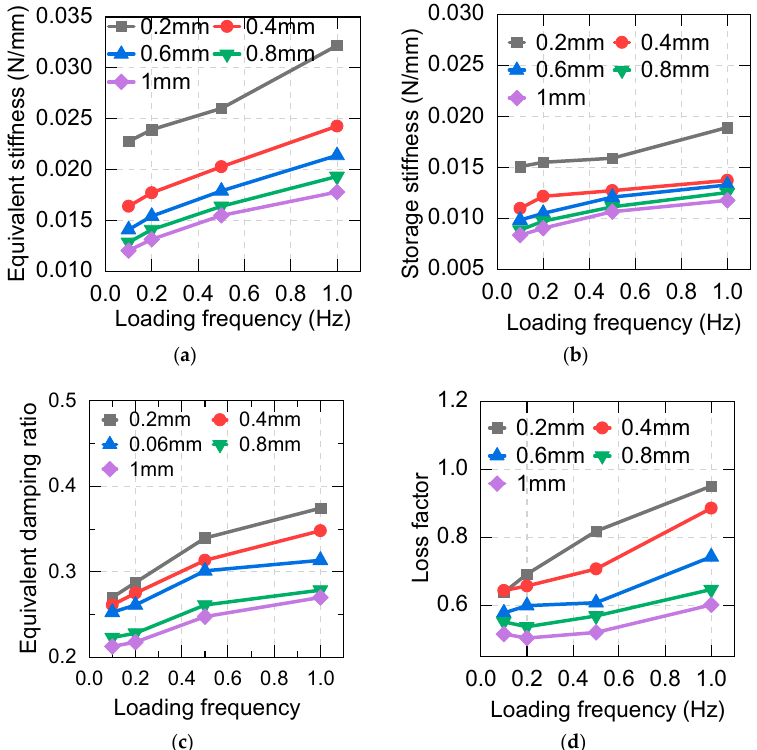
Figure 5. Dependence of the damping properties of asphalt on the loading frequency: ( a ) equivalent stiffness; ( b ) storage stiffness; ( c ) equivalent damping ratio; ( d ) loss factor.